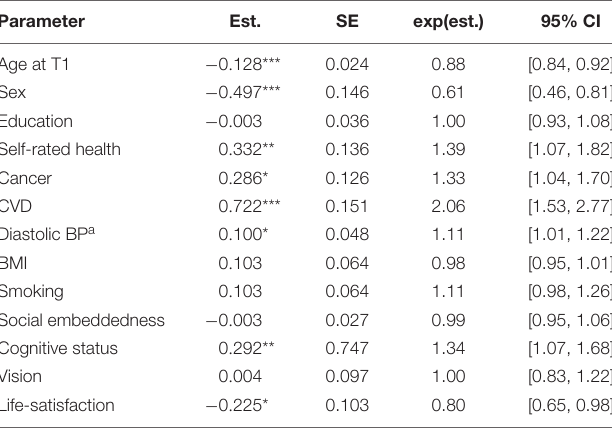
TABLE 5 | Parameter estimates from Cox proportional hazard models with age of death as outcome and a combination of variables from different categories as